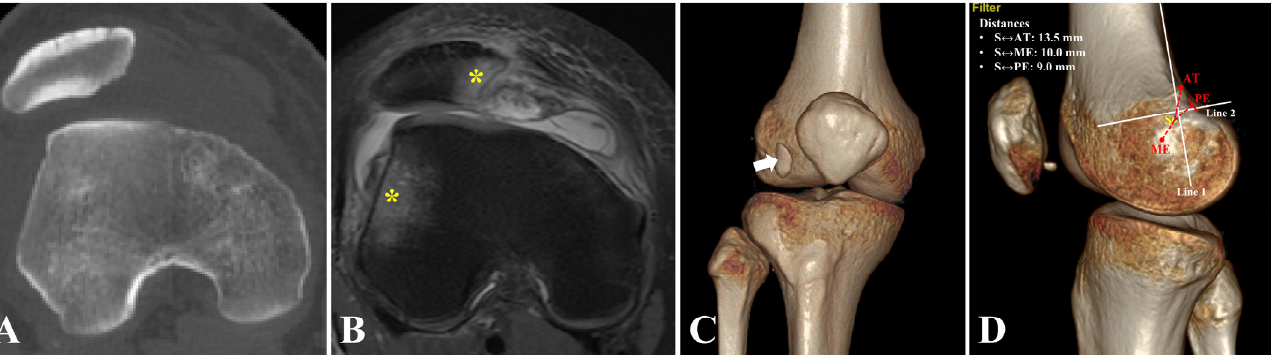
Figure 1. Preoperative imaging evaluation. Right knee. ( A ) Axial CT scan showing lateral patellar translation. ( B ) Magnetic resonance imaging showing kissing contusion of the medial patella and the lateral femoral condyle (yellow asterisks). ( C ) Anterior view of three-dimensional CT reconstruction showing an intra-articular loose body (arrow). ( D ) Medial view of three-dimensional CT reconstruction showing measurements between the ideal femoral attachment of the MPFL and three anatomic landmarks. The ideal position is assessed with Schöttle’s point (yellow spot). Line 1 is the extension of the posterior cortical line. Line 2 is the line perpendicular to line 1 intersecting the posterior origin of the medial femoral condyle. Schöttle’s point is located 1.3 mm anterior to line 1 and 2.5 mm distal to line 2. Preoperative measurements demonstrate that the ideal femoral tunnel lies 13.5 mm to the AT, 10.0 mm to the ME and 9.0 mm to the PE. AT, adductor tubercle. CT, computed tomography. ME, medial epicondyle. PE, posterior edge. S, Schöttle’s